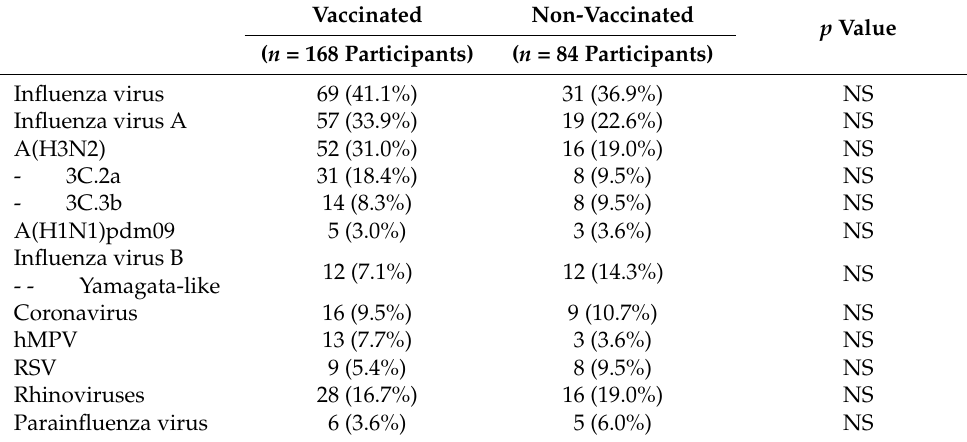
Table 3. Pathogens detected in participants with acute ILI relative to vaccination status in season 2014/2015.